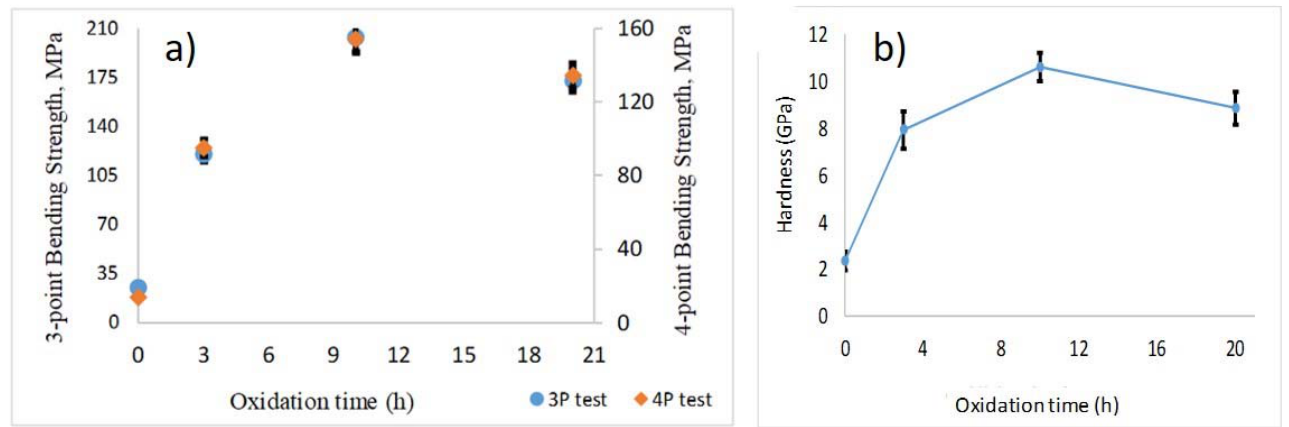
Figure 6. The measured 3-point and 4-point bending strength ( a ) and micro-hardness ( b ) of the sintered AlN-Al 2 O 3 given as function of oxidizing time of the samples.